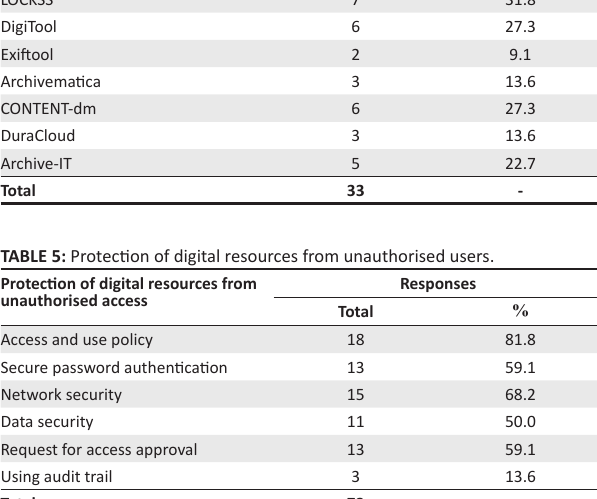
TABLE 4: Types of technologies and tools used for digital preservation. Types of preservation technologies and tools